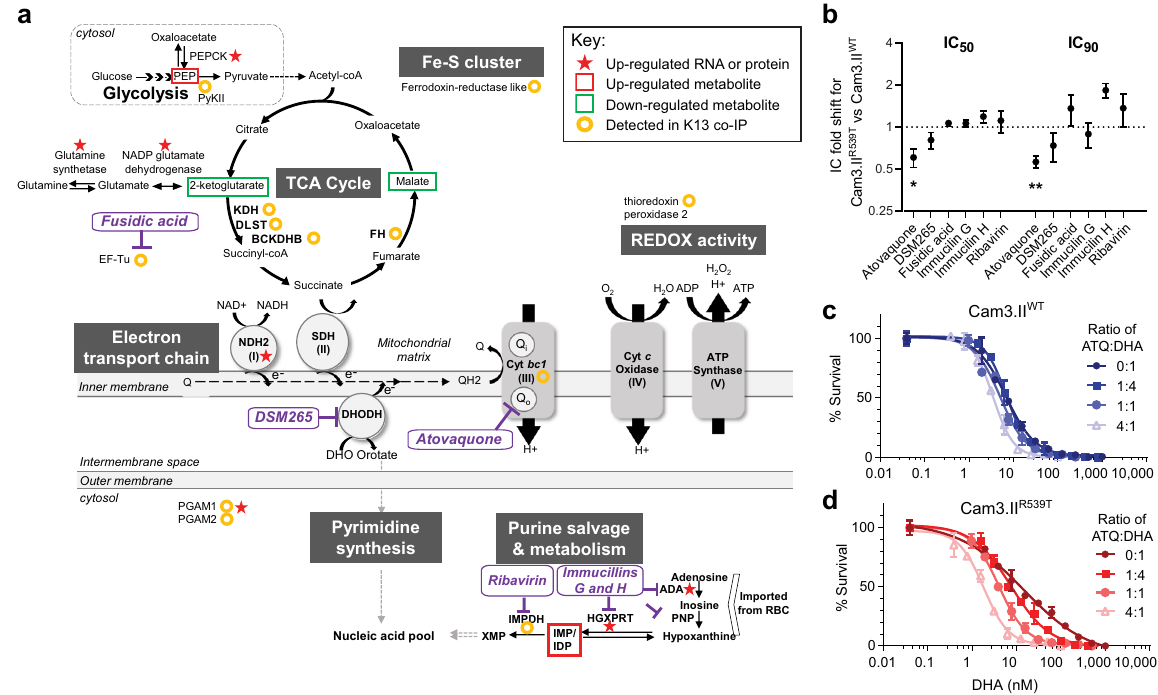
Fig. 5 Multi-omics data and dose – response assays reveals K13 ′ s role in maintaining mitochondrial ETC functions. a Schematic of the energy and purine metabolism pathways in the parasite mitochondrion. Genes, proteins, metabolites, and co-IP proteins that were detected as differentially regulated between isogenic K13 mutant and WT parasites in multi-omics experiments are highlighted. ADA adenosine deaminase, DHODH dihydroorotate dehydrogenase, DLST dihydrolipoyllysine-residue succinyltransferase, HGXPRT hypoxanthine-guanine-xanthine phosphoribosyltransferase, IMPDH inosine 5 ′ -monophosphate dehydrogenase, PNP purine nucleoside phosphorylase. For full list of protein names, refer to Supplementary Data 5. b IC 50 and IC 90 fold shifts for Cam3.II R539T vs. Cam3.II WT 0 – 3 hpi early rings exposed for 4 h to a panel of inhibitors targeting mitochondrial processes (atovaquone, DSM265, fusidic acid) or purine metabolism (immucilin G and H, ribavirin). Shown are means ± SEM values from two to fi ve independent experiments with technical duplicates. ** P = 0.008, * P = 0.024, two-tailed one-sample t -tests of the IC fold shift. Individual IC 50 and IC 90 data are provided in Supplementary Data 8. c Four hour dose – response assays conducted on Cam3.II WT 0 – 3 hpi early rings, depicting no change in the DHA dose – response curves in the presence of increased ATQ to DHA ratios. d Four hour dose – response curves show increased sensitization of Cam3.II R539T 0 – 3 hpi early rings to DHA with higher ratios of ATQ to DHA. The mitochondrial ETC inhibitor ATQ displays increased potency when combined with DHA against Cam3. II R539T parasites in 4 h drug treatments. Dose – response assays were performed in three to fi ve independent experiments with technical duplicates for each parasite line. The data presented in c and d are exemplars from one independent experiment with error bars representing the SD between technical duplicates. Also see Supplementary Fig. 9b – e for FIC 50 curves and isobologram